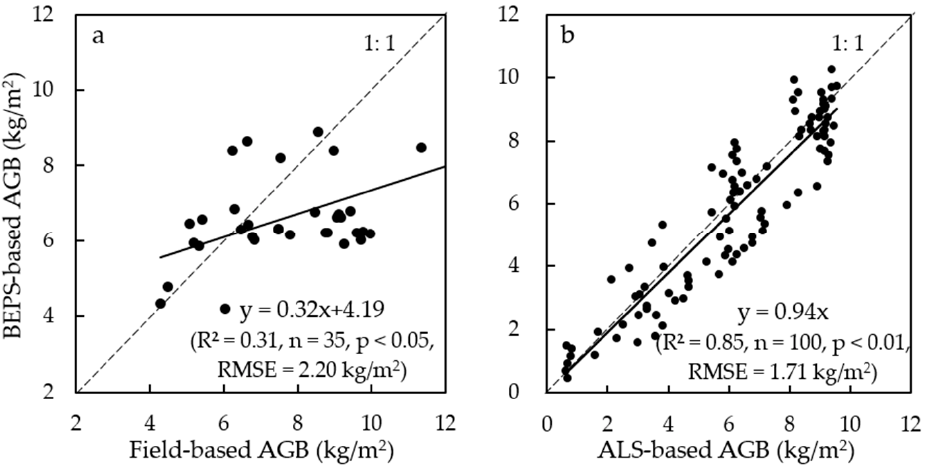
Figure 7. The validation of BEPS-based forest AGB in 2012 using the results obtained from forest field-based AGB ( a ), and ALS-based AGB ( b ) at the plot level.